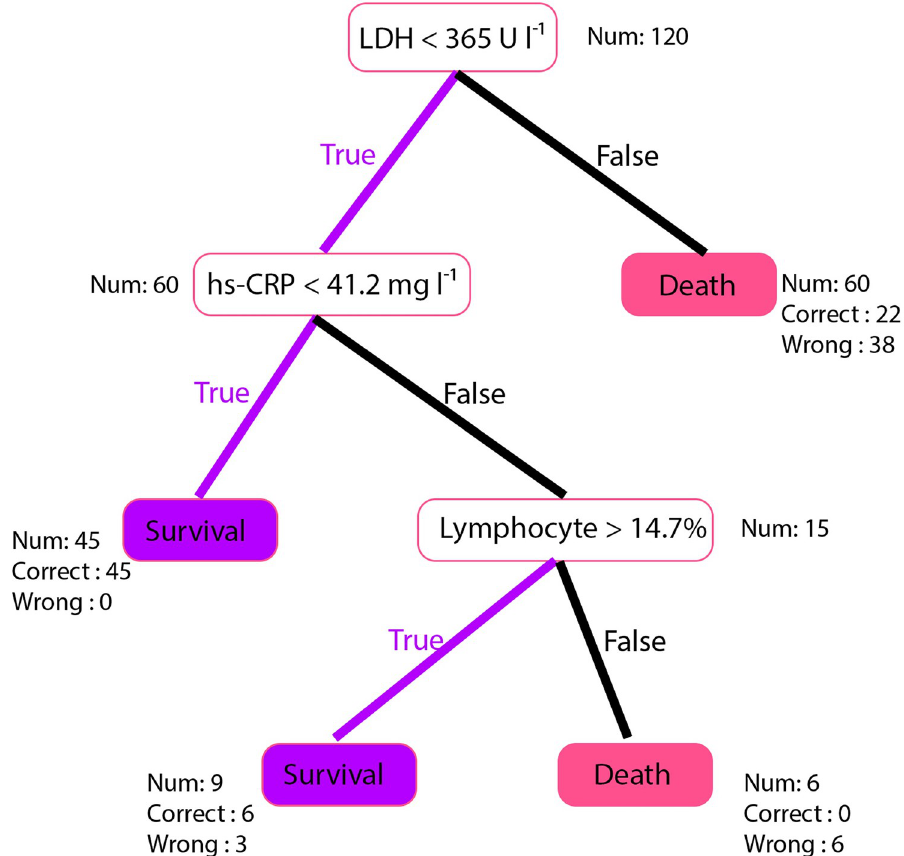
Fig 1. Evaluation of Mortality prediction model from Li Yan et al. on an Indian cohort.